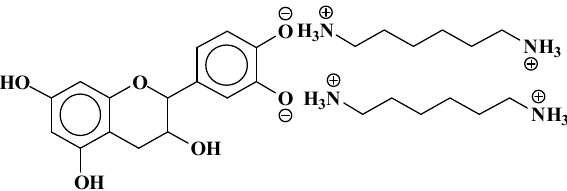
Figure 21. Example of structure of diamines linked to catechin B-ring sites by ionic salt bonds.